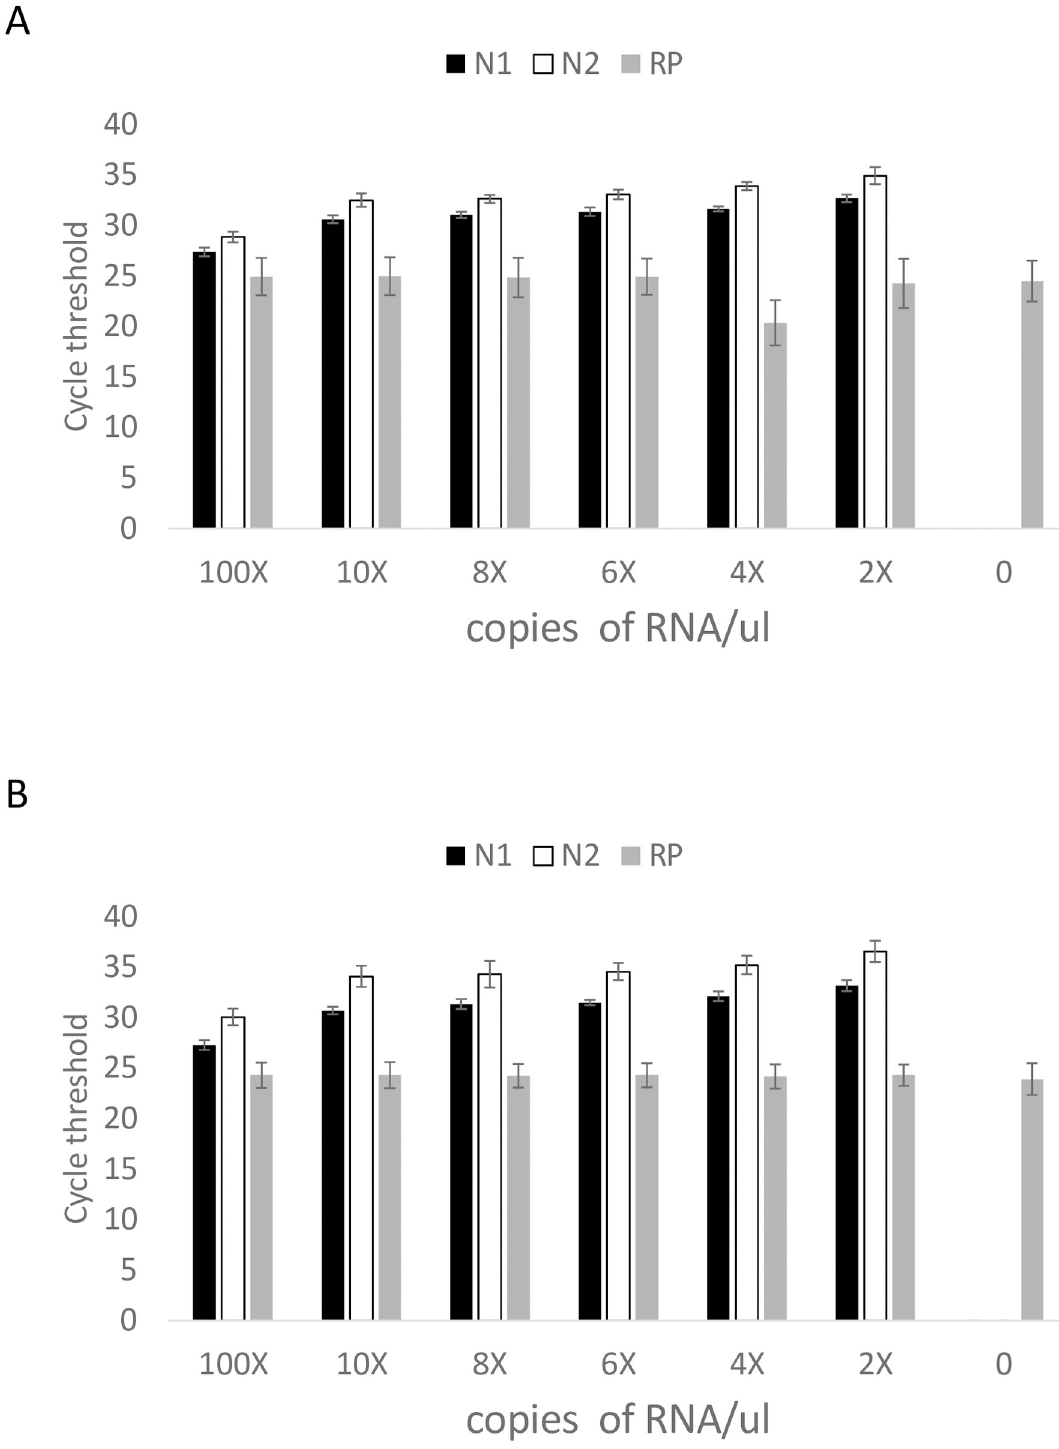
Fig 2. Assay performance with two extraction methods. Specimen matrix spiked with specified concentration of synthetic RNA and extracted using A. phenol and B. column-based methods. Black bars = N1 primer, open bars = N2 primer, gray bars = RNase P primer. Error bars = 1 standard